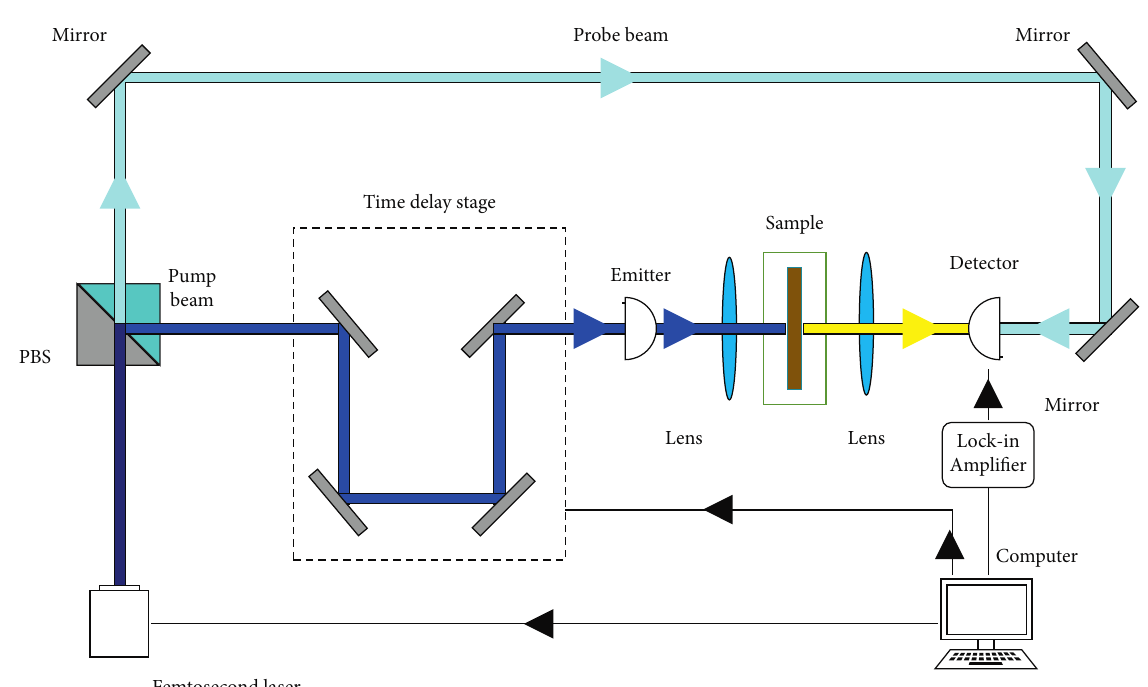
Figure 2: The schematic diagram of the THz-TDS